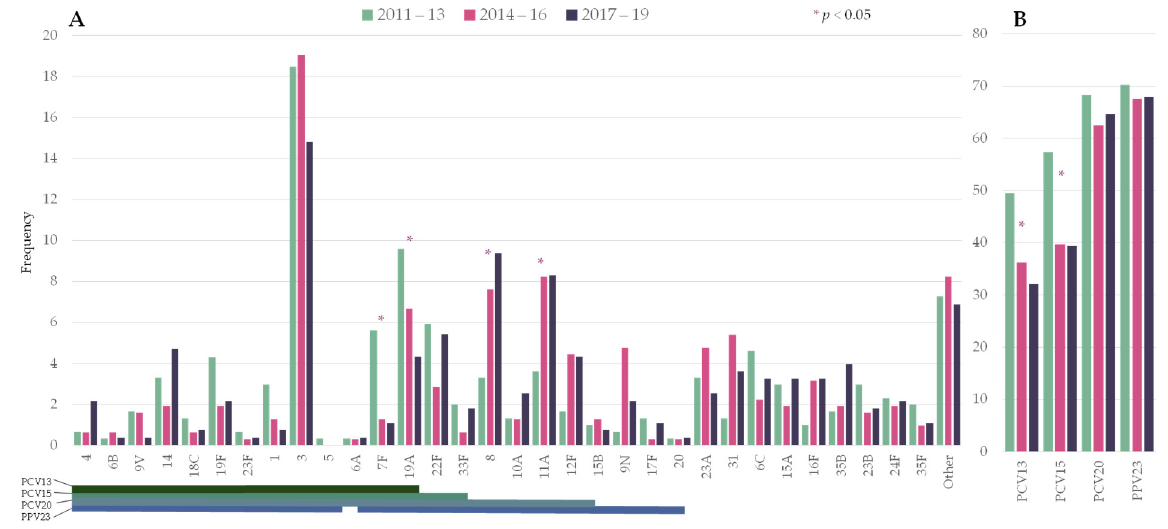
Figure 1. Changes in the serotype distribution of pneumococci causing pneumococcal pneumonia by period. ( A ) Individual serotypes; ( B ) Frequency of episodes caused by serotypes included in pneumococcal vaccines. Asterisks indicate significant changes between 2011–2013 and 2017–19. Lines below the serotypes indicate the serotype composition of the different vaccines. PCV13: 13-valent pneumococcal conjugate vaccine (PCV); PCV15: 15-valent PCV; PCV20: 20-valent PCV; PPV23: 23-valent pneumococcal